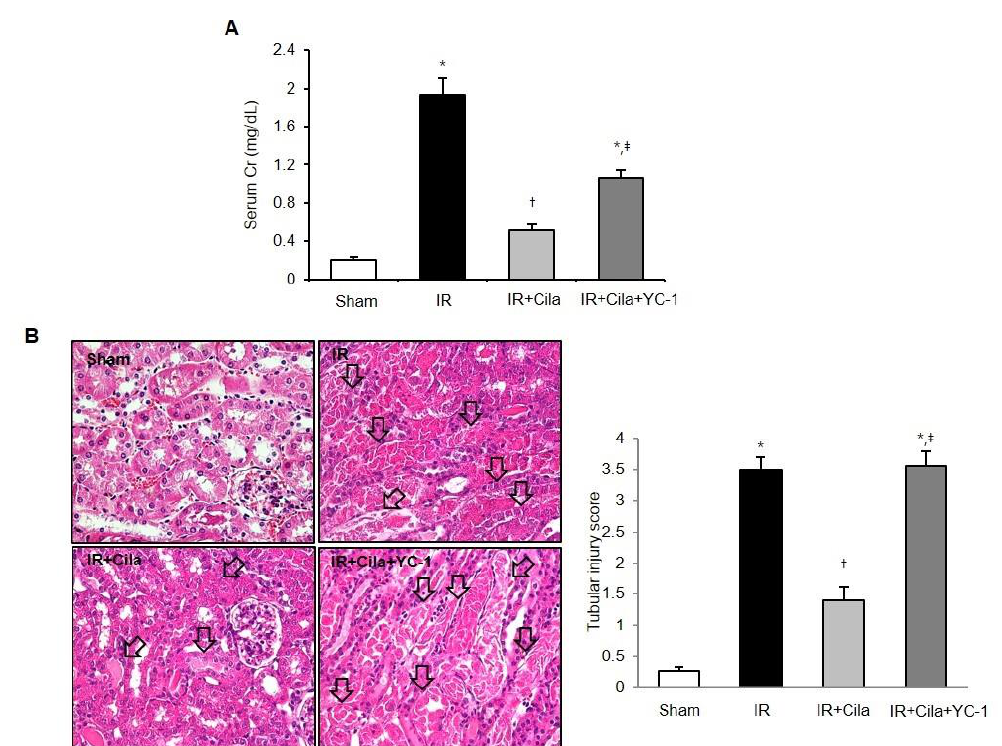
Figure 9. The co-treatment of YC-1, an HIF-1 α inhibitor, with cilastatin worsened renal function and tubular necrosis in mouse kidney with IR injury. ( A ) Serum creatinine levels were significantly increased at 24 h after IR injury and decreased in mouse kidney with IR injury with cilastatin pretreatment. Co-treatment with cilastatin and YC-1 exacerbated renal function in mouse kidney with IR injury. ( B ) The representative staining with hematoxylin and eosin showed a decreased tubular necrosis (arrows) in the cilastatin-treated mouse kidney with IR injury, and aggravated tubular necrosis in mouse kidney with IR injury co-treated with cilastatin and YC-1 (original magnification, × 200). The data are presented as means ± SEM. * p < 0.05 vs. sham; † p < 0.05 vs. IR group; ‡ p < 0.05 vs. IR + Cila group.